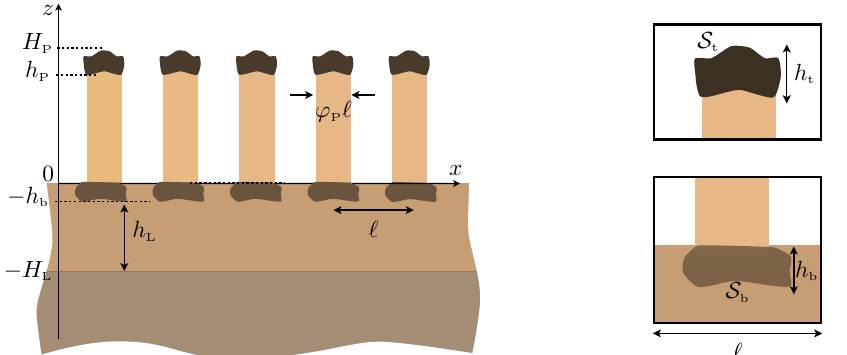
Figure 1. Periodic array of plates decorated at their endings with spacing (cid:96) = 1, height h (cid:96) ; the substrate occupying a half-space is surmounted by a guiding layer of thickness h ϕ P support Love waves. The insets show a zoom on the two endings with heterogeneity surfaces = ϕ h and b b S b